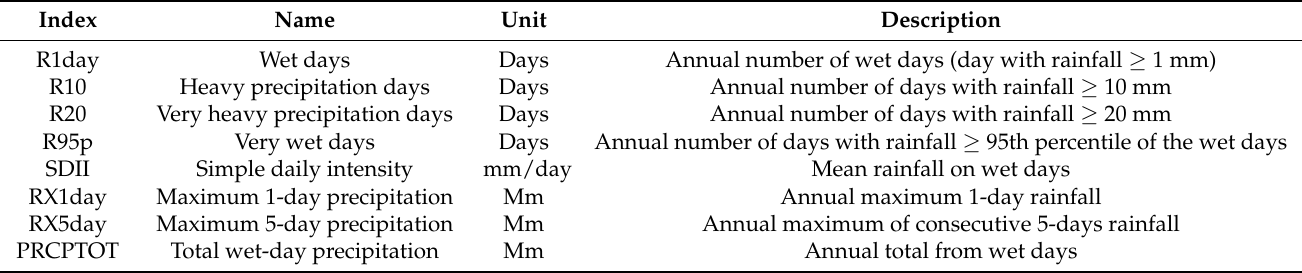
Table 1. Precipitation indices were used in this study to characterize (extreme) rainfall